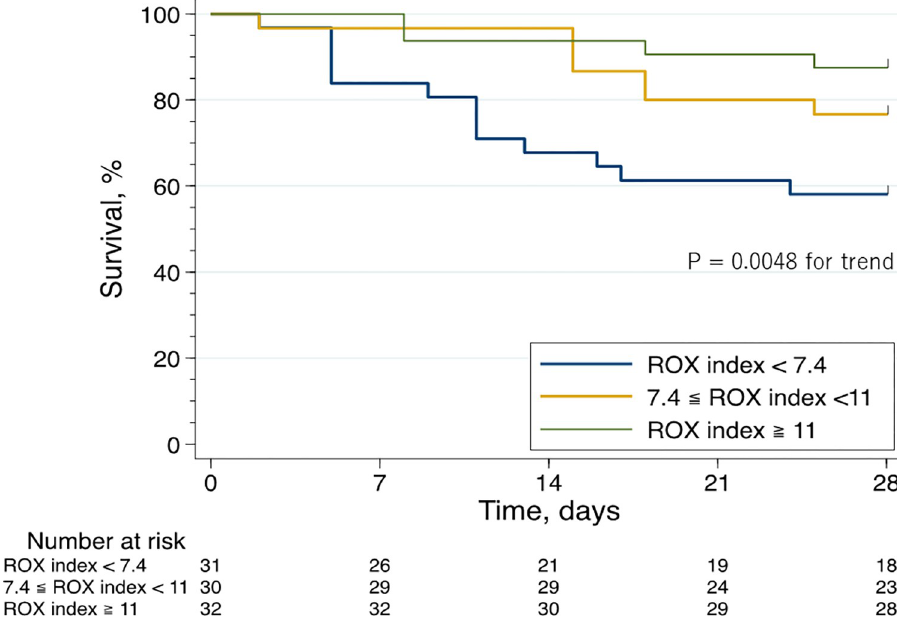
Fig 2. Kaplan–Meier curve analysis of the 28-day survival stratified by the ROX index.